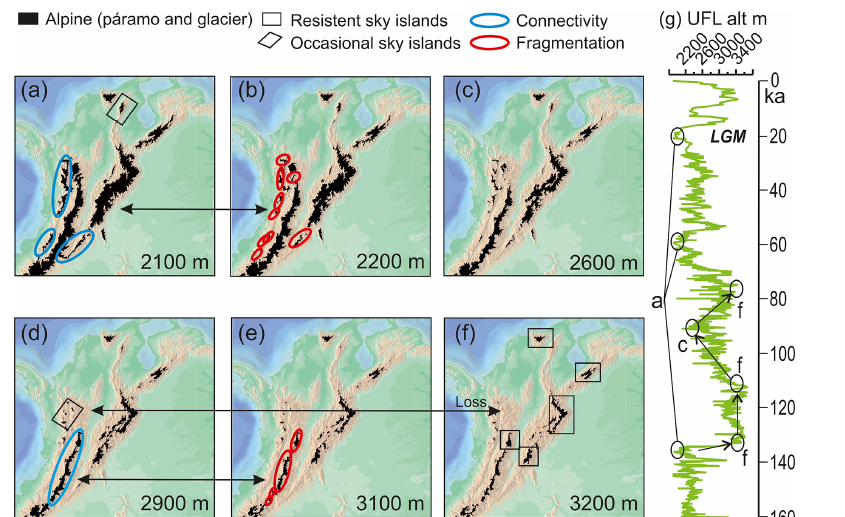
Figure 9. The 160ka interval of composite pollen record of Fúquene 9C (g) , showing that the upper forest line (UFL) positions varied between 2000 and 3200m (a–f) . Using UFL positions as input for a digital elevation model, simplified maps of the spatial distribution of páramo vegetation were reconstructed (Flantua and Hooghiemstra, 2018). In the Northern Andes, páramo distribution varied between a glacial maximum extension (UFL at 2000m) and an interglacial minimum extension (UFL at 3200m). During periods of increased temperatures (at the frequent stadial–interstadial transitions and during the few glacial–interglacial transitions), the distribution of páramo vegetation shows marked events of fragmentation in the Western Cordillera (UFL at 2200m), Venezuelan Cordillera (UFL at 2600m), Eastern Cordillera (UFL at 2900m), and Central Cordillera (UFL at 3100m), depending on the mountain-specific profile or mountain fingerprint (Flantua and Hooghiemstra, 2018; Flantua et al., 2019). Long continental pollen records serve a new field of research and hypothesis testing for different